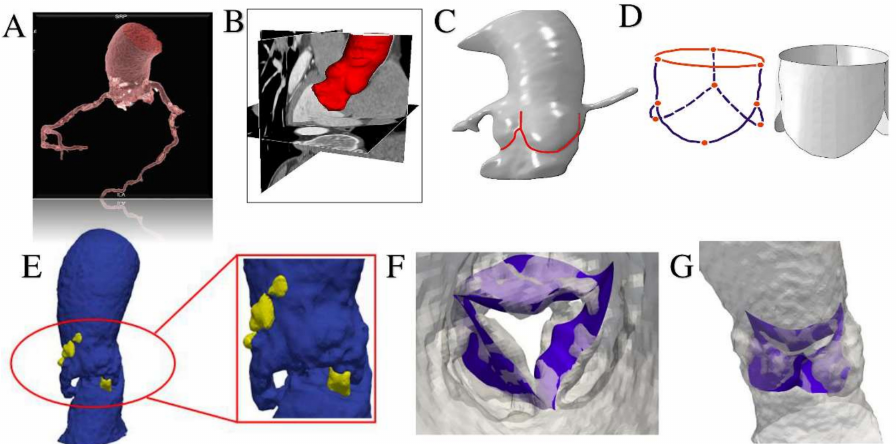
Figure 5. Using Rhinoceros 3D (McNeel & associates, Seattle, WA, USA) and Simulia Abaqus we